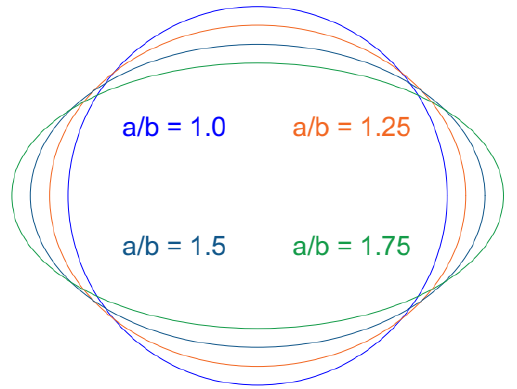
Figure 6. Elliptical shapes with different a/b ratios.